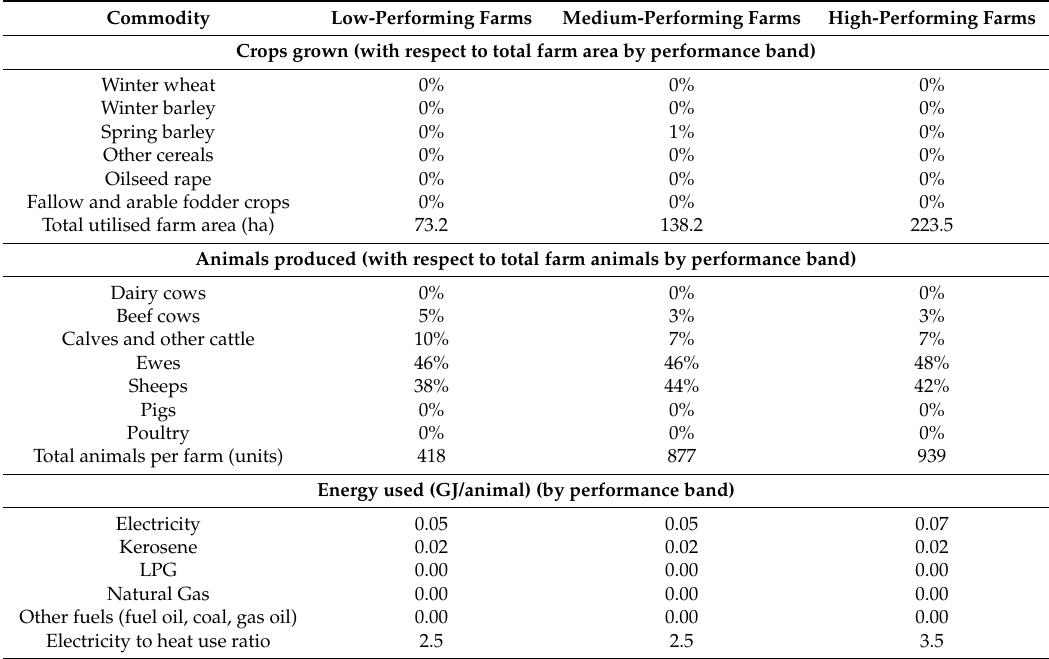
Table 5. Annual less-favourable area (LFA) farm input and output characteristics